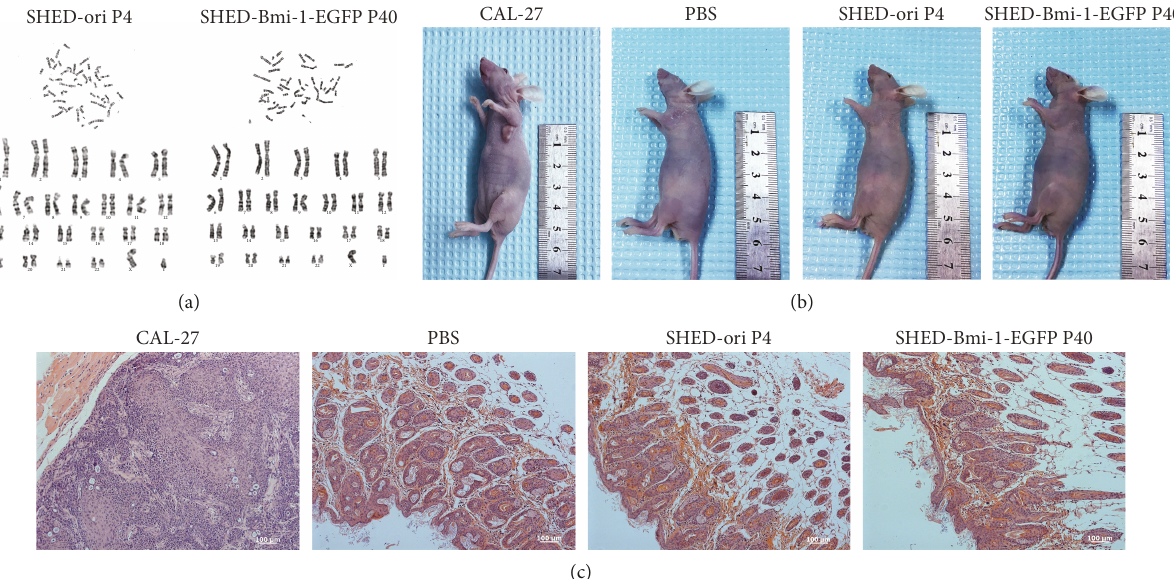
Figure 4: Assessment of potential tumourigenicity ability of SHED-Bmi1-EGFP. (a) Cytogenic analysis of immortalized cells. SHED-Bmi1-EGFP P40 showed no abnormality of karyotype. (b) Assessment of potential tumourigenicity of SHED-Bmi1-EGFP in vivo . In a total of 5 weeks after injections of cells into the left forelimb armpit, no tumour formation was seen in PBS, SHED-ori P4, or SHED-Bmi1-EGFP P40 group. (c) Tumour slides stained with haematoxylin and eosin dye. Positive control showed heteromorphism while PBS, SHED-ori P4, and SHED-Bmi1-EGFP P40 did not. Scale bar, 100 μ m.